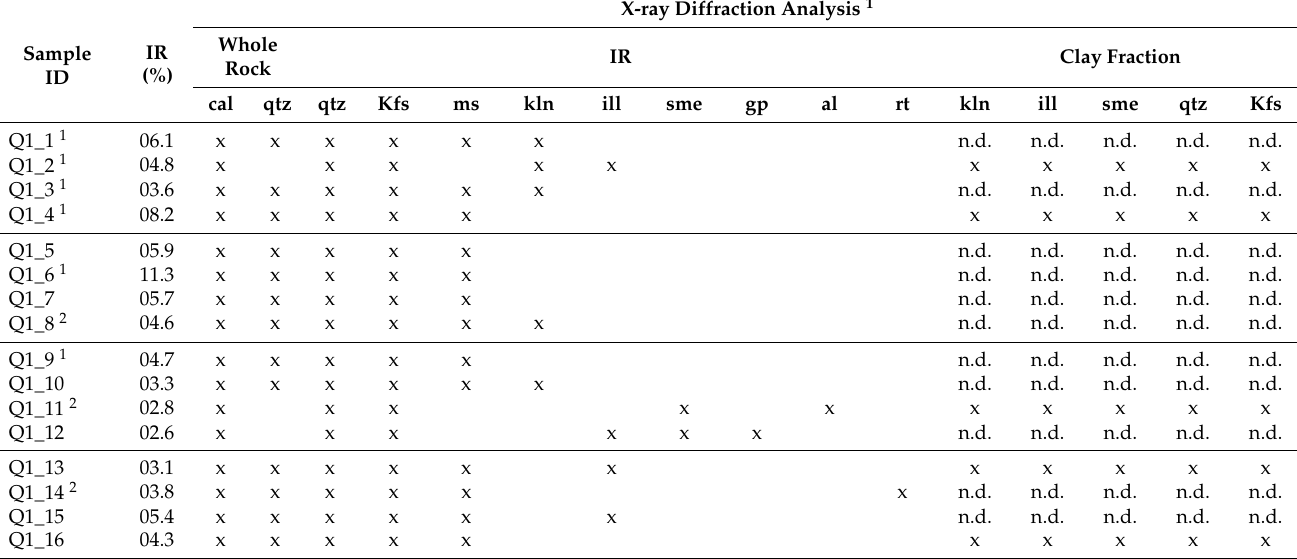
Table 4. IR and X-ray diffraction analysis: summary of identified